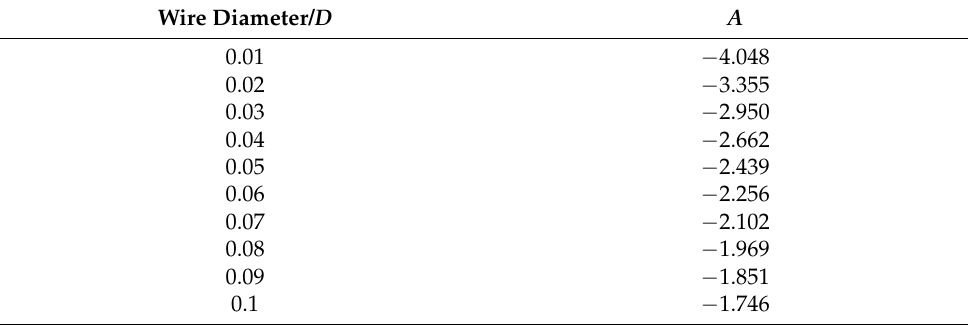
Table 1. Correction values of constant A in Equation (3) from 0.01 to 0.1.